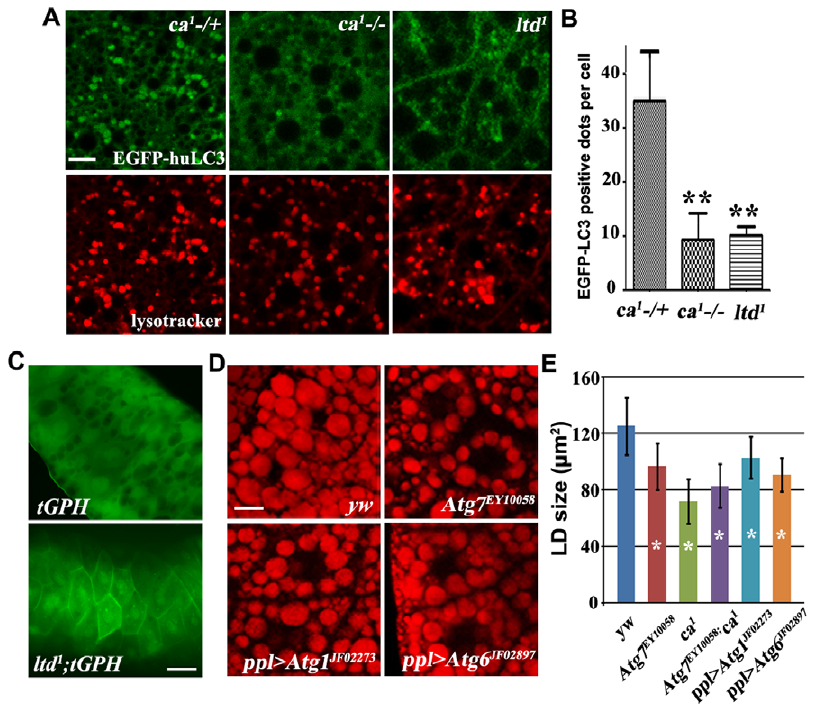
Figure 6. Autophagy is impaired in ca mutants and defective autophagy leads to small lipid droplets. (A) Autophagy marker EGFP- huLC3-positive puncta are greatly reduced in ltd 1 and ca 1 homozygous mutants compared to the ca 1 heterozygous control. Scale bar: 20 m m. (B) Quantification of EGFP-huLC3-marked autophagosomes in ca 1 heterozygous and ltd 1 and ca 1 homozygous mutants. The error bars represent the standard deviation. **: P , 0.001. (C) tGPH reporter in control and ltd 1 mutant salivary glands at 13.5 hr after pupae formation. tGPH cortical signal persists in ltd 1 mutants. Scale bar: 50 m m. (D) Nile red staining of lipid droplets in wandering stage third instar larval fat body cells. Autophagy mutants or Atg1 and Atg6 RNAi animals have small lipid droplets. Scale bar: 20 m m. (E) Quantification of lipid droplet size in different genetic backgrounds. The error bars represent the standard deviation. *: P , 0.001.